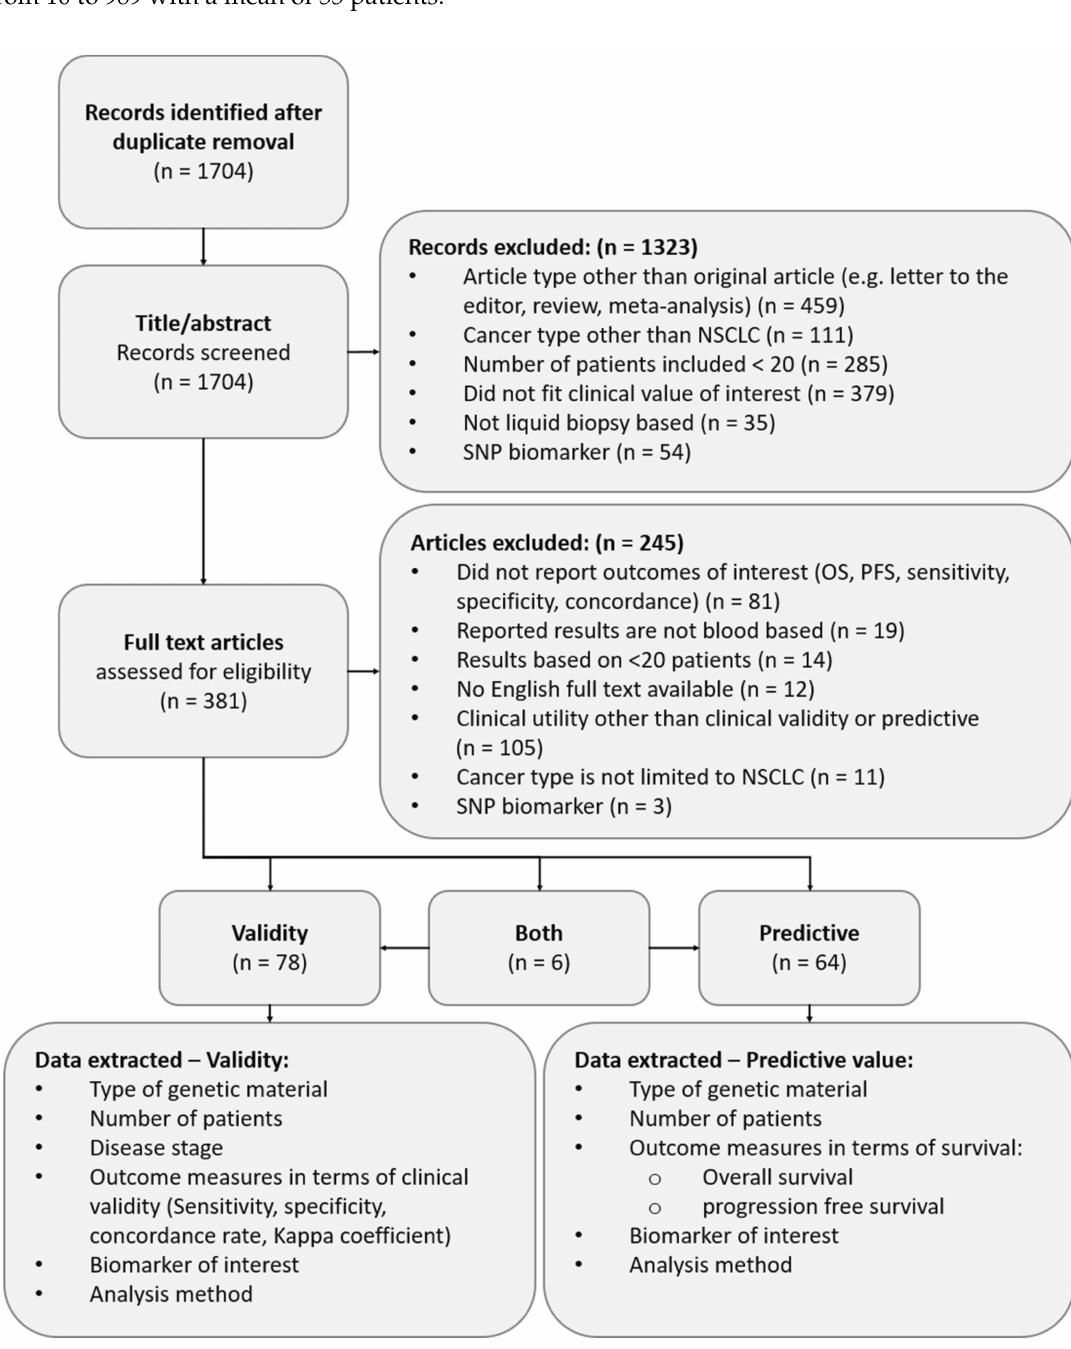
Figure 1. Study selection flow chart. (Non-small cell lung cancer: NSCLC, single nucleotide polymorphism: SNP, Overall survival: OS, Progression free survival: